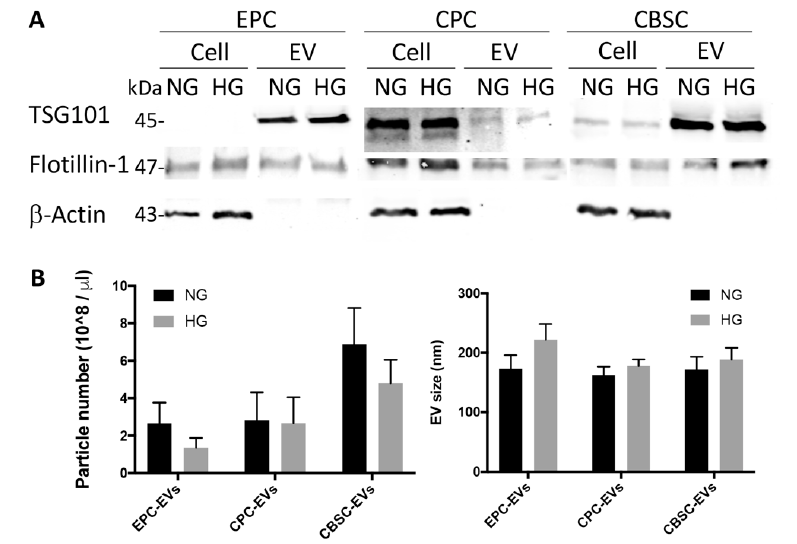
Figure 1. Endothelial progenitor cell (EPC)-, cardiac progenitor cell (CPC)-, and cortical bone stem cell (CBSC)-derived EV characterization in NG and HG conditions. ( A ) EVs were identified using EV protein markers, TSG101 and flotillin-1, and a negative marker, β -actin, by Western blot analysis. ( B ) EV particle size and exact particle number of NH and HG groups were measured by Nanosight. All Data shown as mean ± SEM.